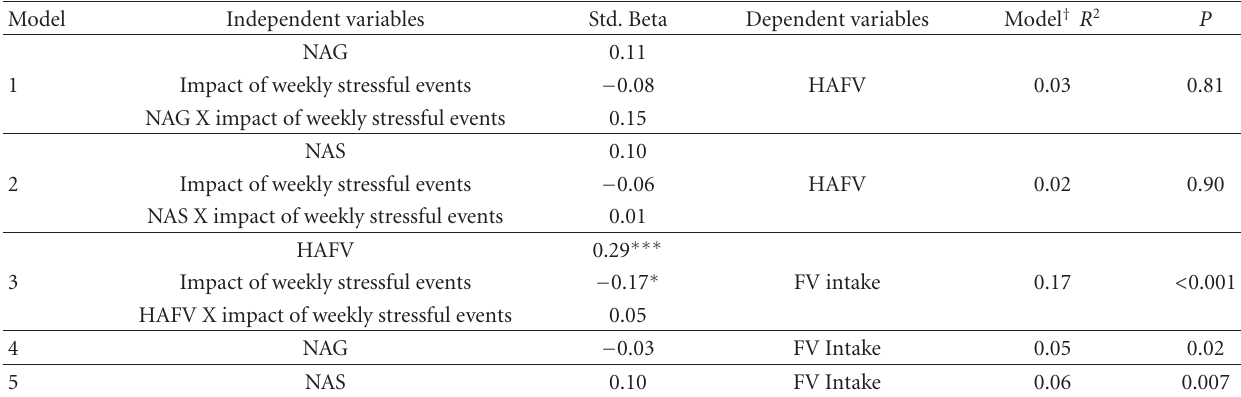
Table 3: Linear regression analyses of the association of home availability of fruit and vegetables and fruit and vegetable intake with neighborhood availability of grocery stores and supermarkets, impact of weekly stressful events, home availability of fruit and vegetables, and interaction e ff ects after controlling for demographic variables among African American and Hispanic or Latino women from Health Is Power †